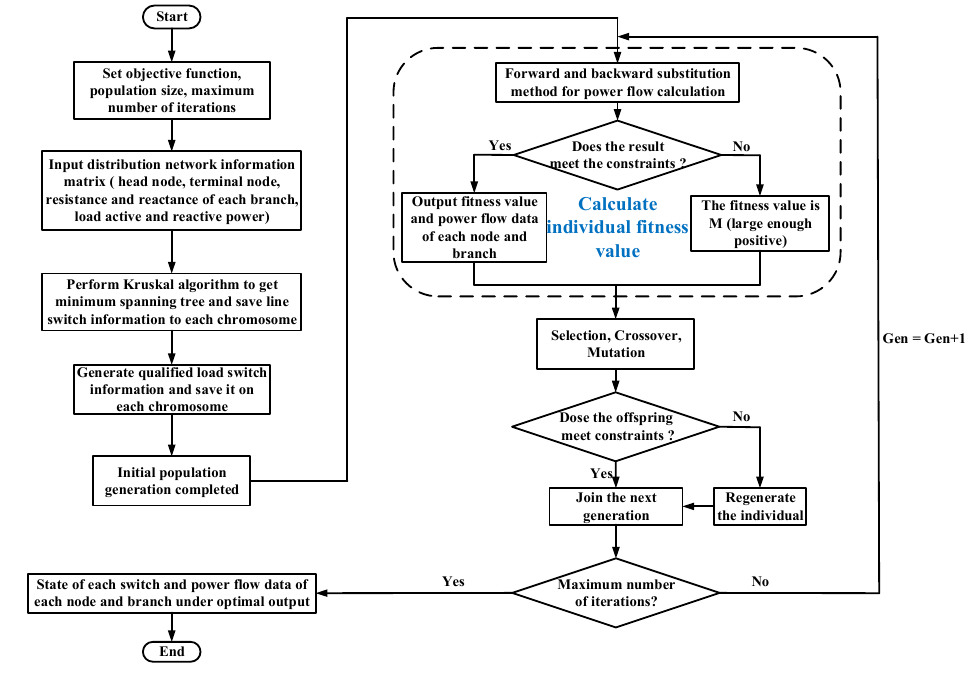
Figure 1. Flowchart of the solving